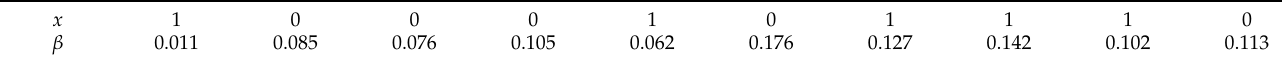
Table 6. Calculation sample of “ignorability” of data in time